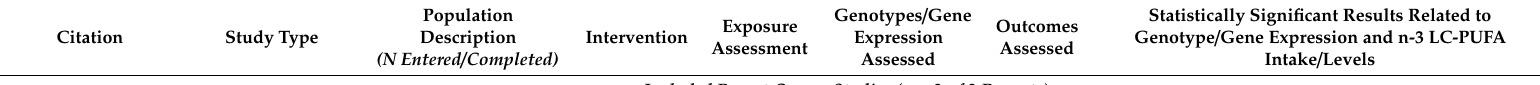
Table 2. Evidence table of included